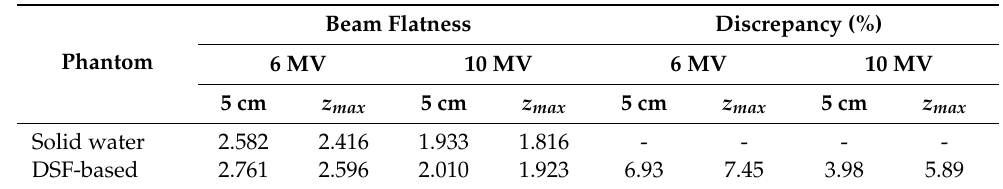
Figure 9. Beam profile for 10 MV photons measured at: ( a ) d max and ( b ) d ref . Table 10. Beam profile flatness for DSF/NaOH/IA-PAE/ R. spp. particleboards (sample A 15 ) com- pared to that of solid water phantom for 6 MV and 10 MV photons.